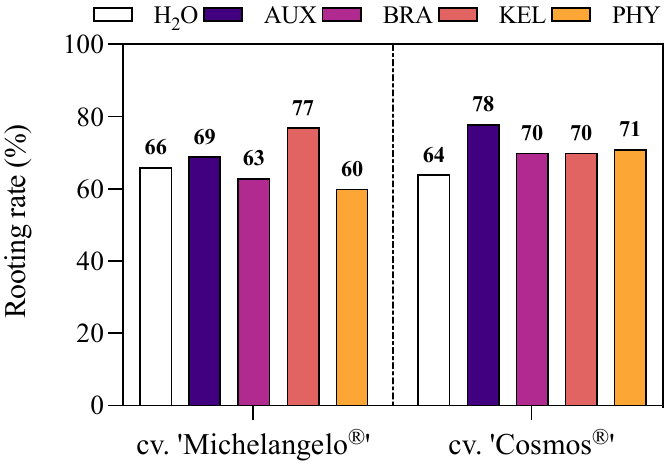
Figure 1. Rooting rate (%) of cv. ‘Michelangelo ® ’ and ‘Cosmos ® ’ cuttings. Values were calculated on the 900 total cuttings. Cuttings were treated with: H 2 O = distilled water; AUX = auxins; BRA = homobrassinolide; KEL = Kelpak ® ; PHY = Phylgreen.